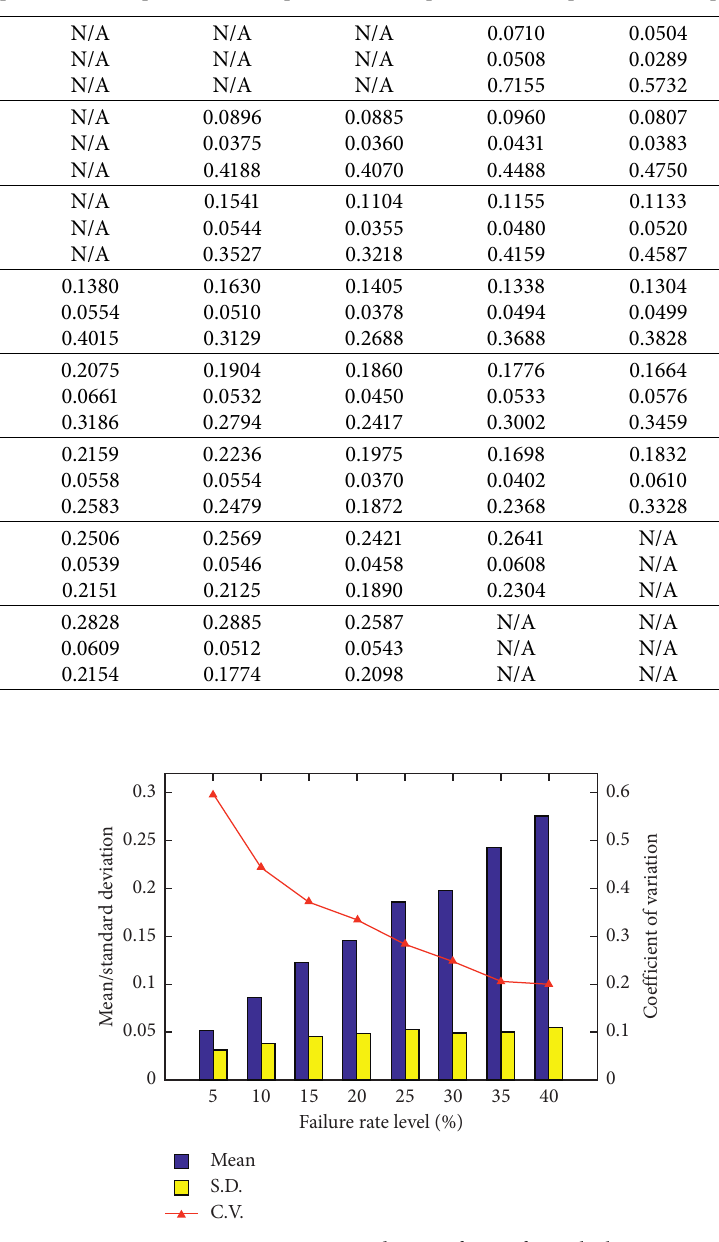
Figure 5: Average mean, S.D., and C.V. of FDR for eight bus